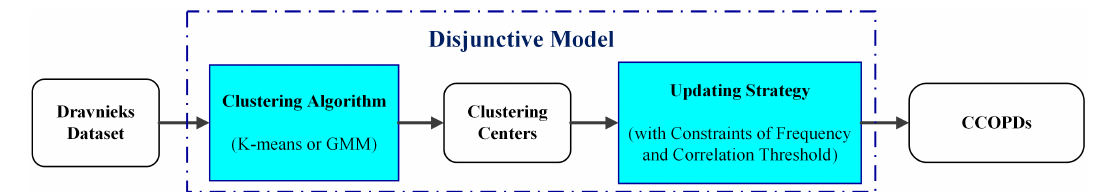
Figure 3. The identification of the cluster-centering odor perception descriptors by the disjunctive model. The clustering algorithm is conducted to obtain clustering centers. Then, CCOPDs are derived from the clustering centers by an updating strategy under the constraints of frequency and correlation threshold